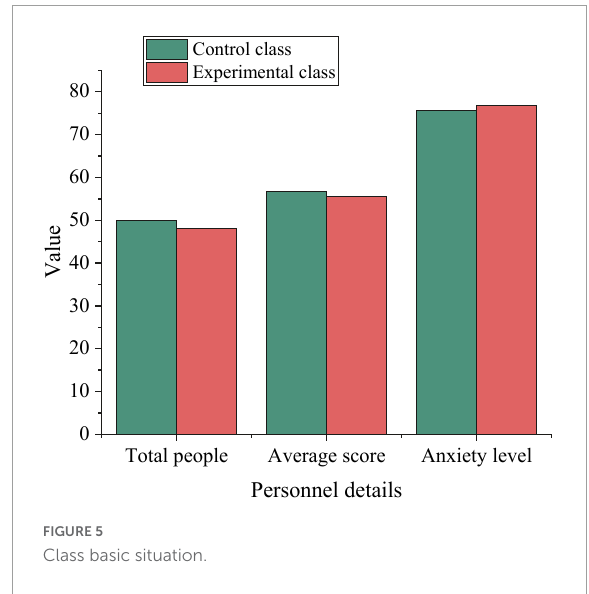
FIGURE5 Class basic